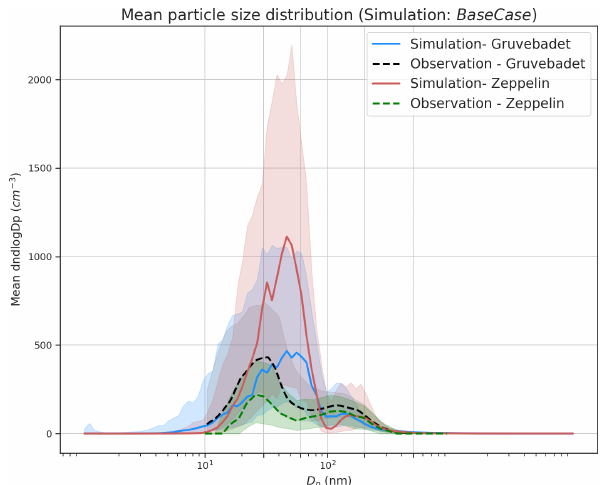
Figure 4. Gas-phase concentrations at Gruvebadet for the BaseCase simulations. The red dots indicate the mean measured values from an earlier 2017 May campaign conducted at Gruvebadet by Beck et al.